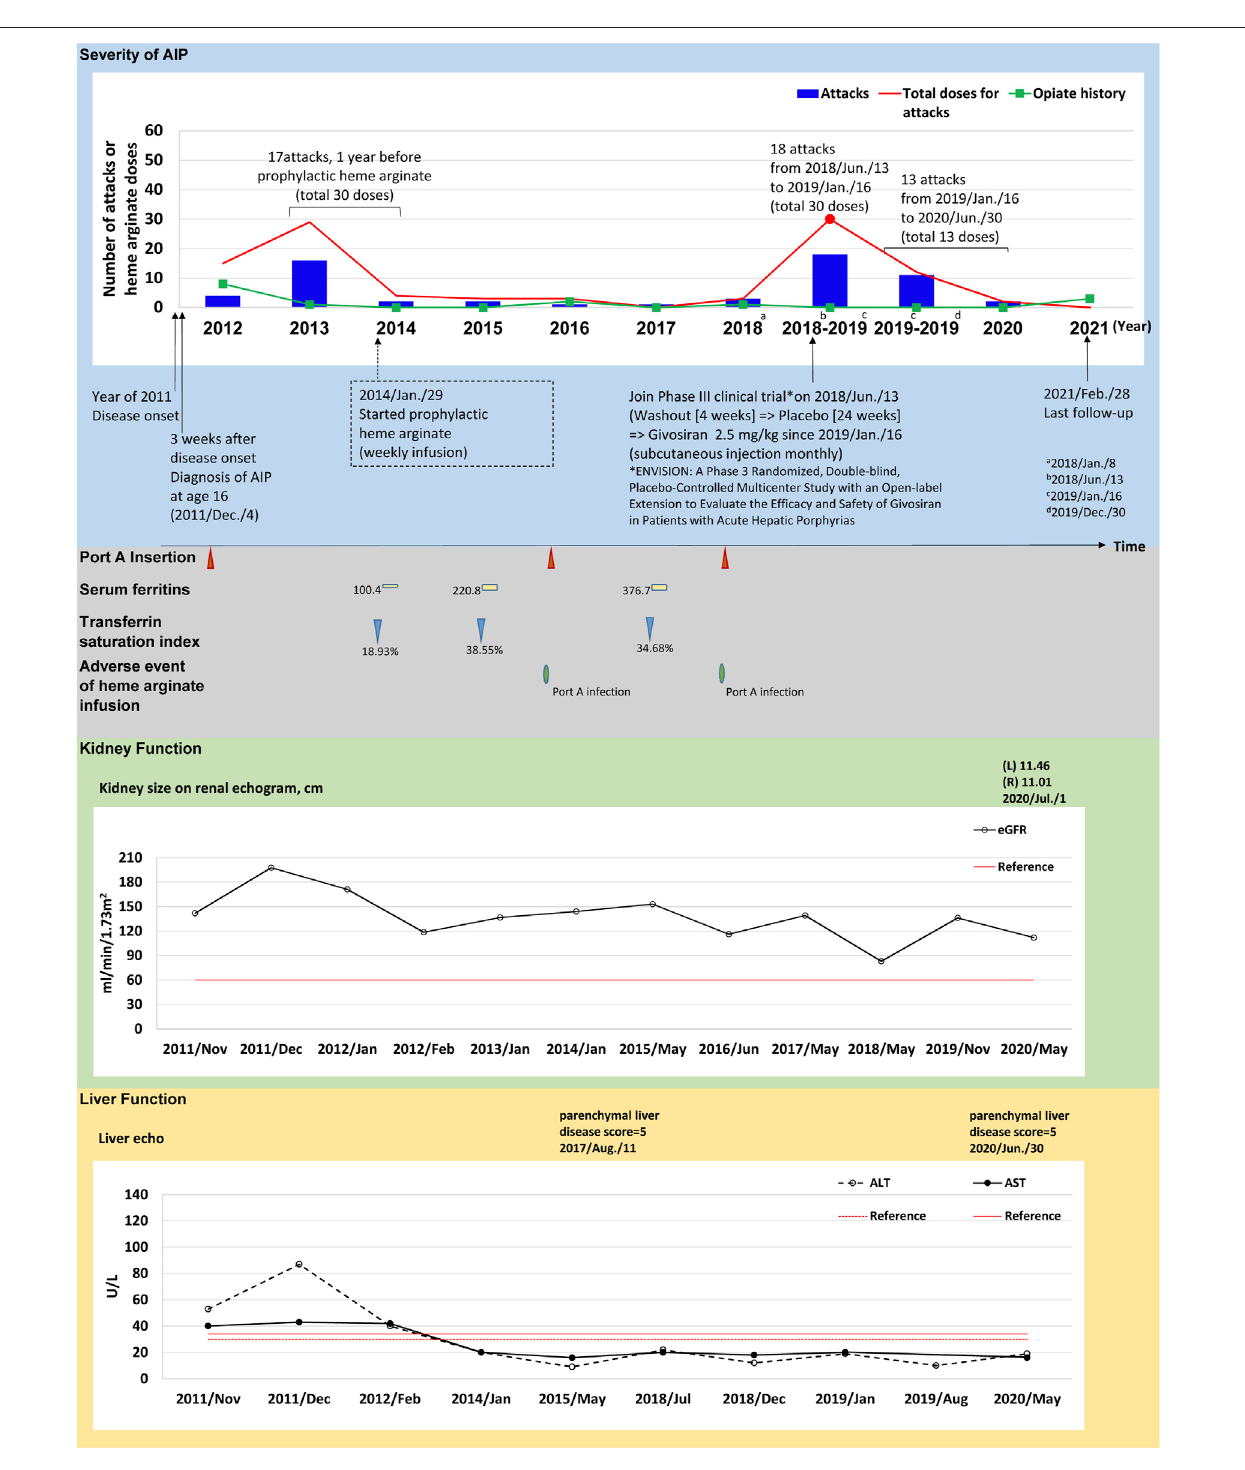
FIGURE1| ThetrackedinformationofAIPseverity,adverseevents,kidneyandliverfunctionforpatient#3.AIPseverityisidenti fi edbynumbersofattacksandtotal hemearginatedosesforporphyricattackstreated.Blackdotsindicatethemostsevereattack inthepast,whichwastreatedusinghemearginate.ReddotsindicateAIP severity status within 1-year before receiving prophylactic heme arginate. A dotted frame marks the initiation date of initial prophylactic heme arginate infusion. Port A insertionandadverseeventsofhemearginateinfusionareshownasredtrianglewithgivenexamineddate,PortA-relatedinfectionisshownasagreenoval.Serum ferritin is indicated as yellow square. Transferrin saturation index (% of serum iron relative to TIBC) is shown as blue triangle. Kidney function is recorded as eGFR level, andsizesofleft(L)andright(R)sideofkidneyalongwithexamineddate.LiverfunctionisrecordedasALTandASTlevels,andparenchymalliverdiseasescorealongwith examined